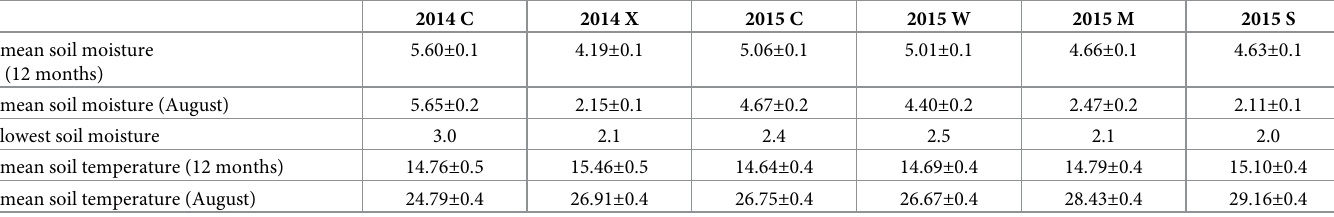
Table 1. Environmental